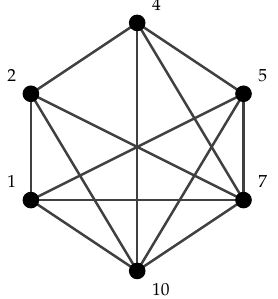
Figure 4. Graph G S for S = < 3,8,13 > .